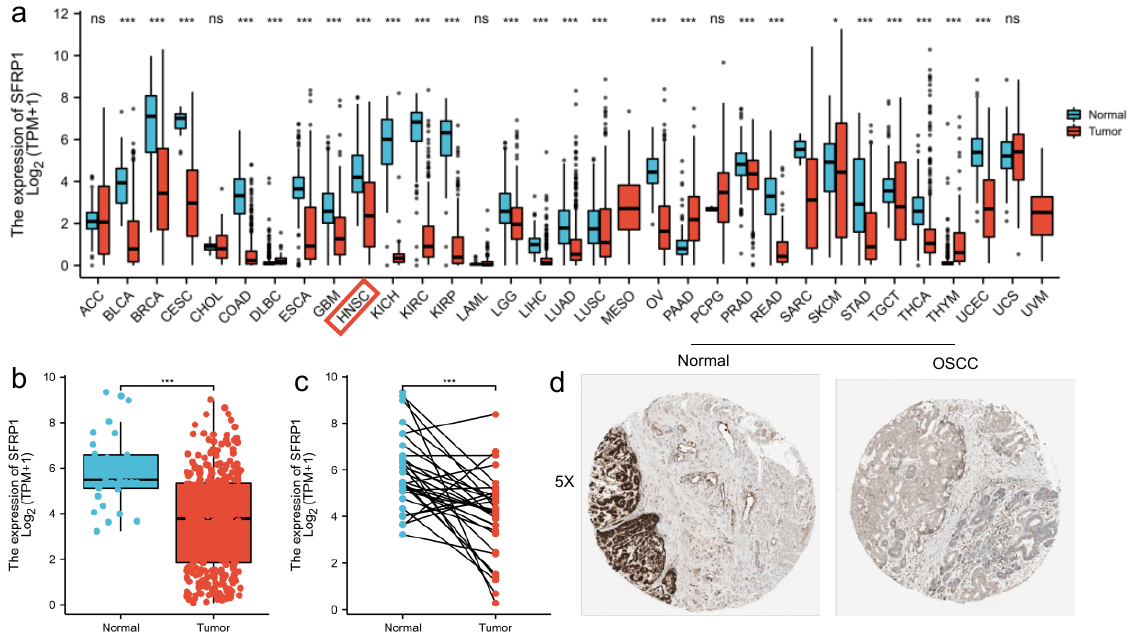
Figure 2 . SFRP1 expression between cancer and normal tissues. ( a ) Expression levels of SFRP1 in solid tumors and adjacent noncancerous tissues containing 33 tissues from TCGA. The red box shows expression level of SFRP1 in head and neck cancers (* p < 0.05, *** p < 0.001). ( b ) Boxplot of SFRP1 expression levels in OSCC and matched normal tissues ( p < 0.001). ( c ) Quantification of SFRP1 IHC staining in OSCC and matched normal tissues ( p < 0.001). ( d ) Representative images of IHC in oral cancer tissue and control tissue.